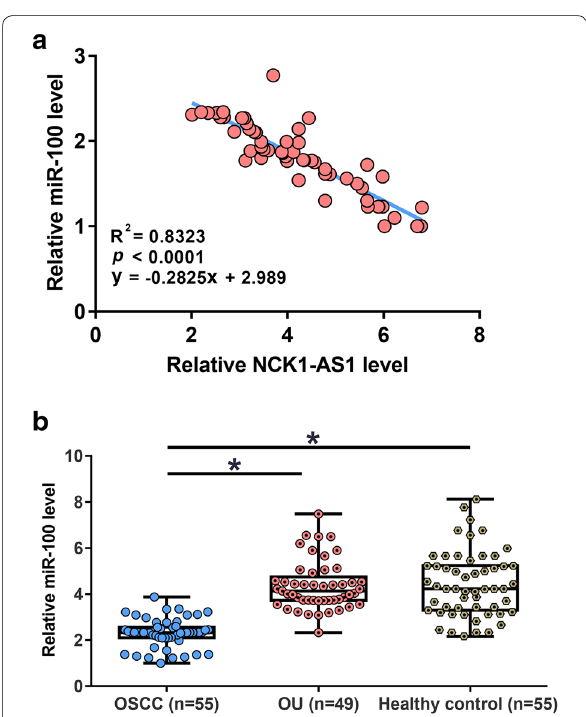
Fig. 3 The expression of miR-100 was inversely correlated with NCK1-AS1. ROC curve analysis showed that plasma miR-100 and NCK1-AS1 were inversely and significantly correlated in OSCC patients ( a ). The expression of miR-100 in 55 early-stage OSCC patients, 49 OU patients, and 55 healthy participants were detected by RT-qPCR. It was observed that plasma levels of miR-100 were significantly lower in OSCC patients in comparison to that in OU patients and healthy participants ( b ). * p <